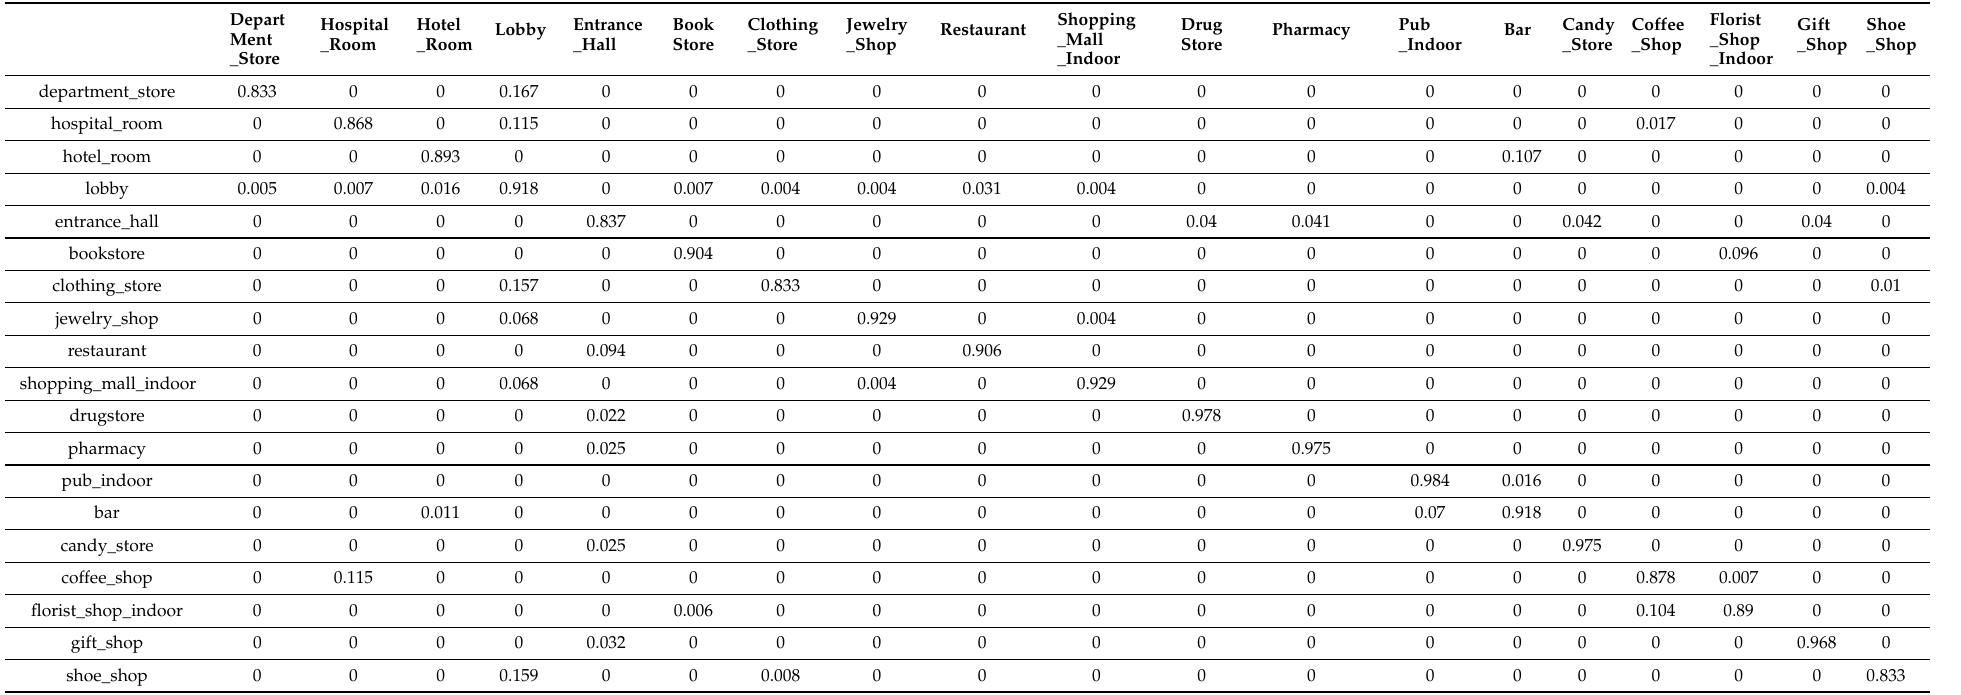
Table 1. State transition matrix of the shopping